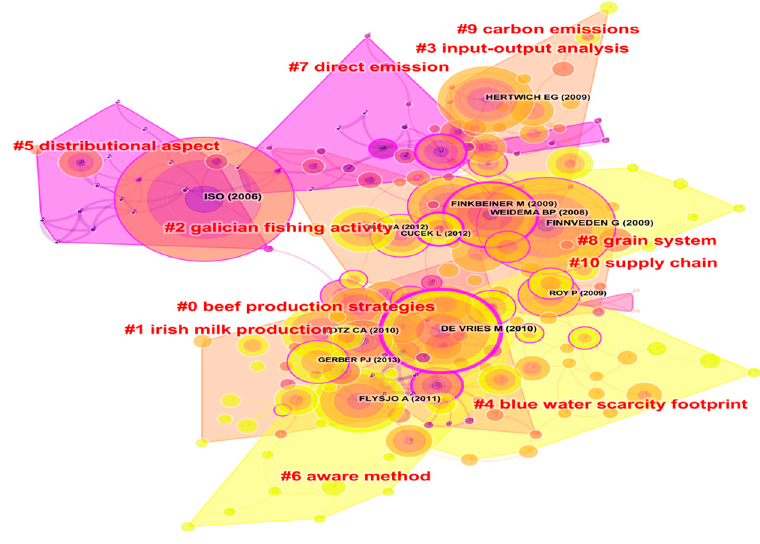
Figure 5. Document co-citation network with clusters.